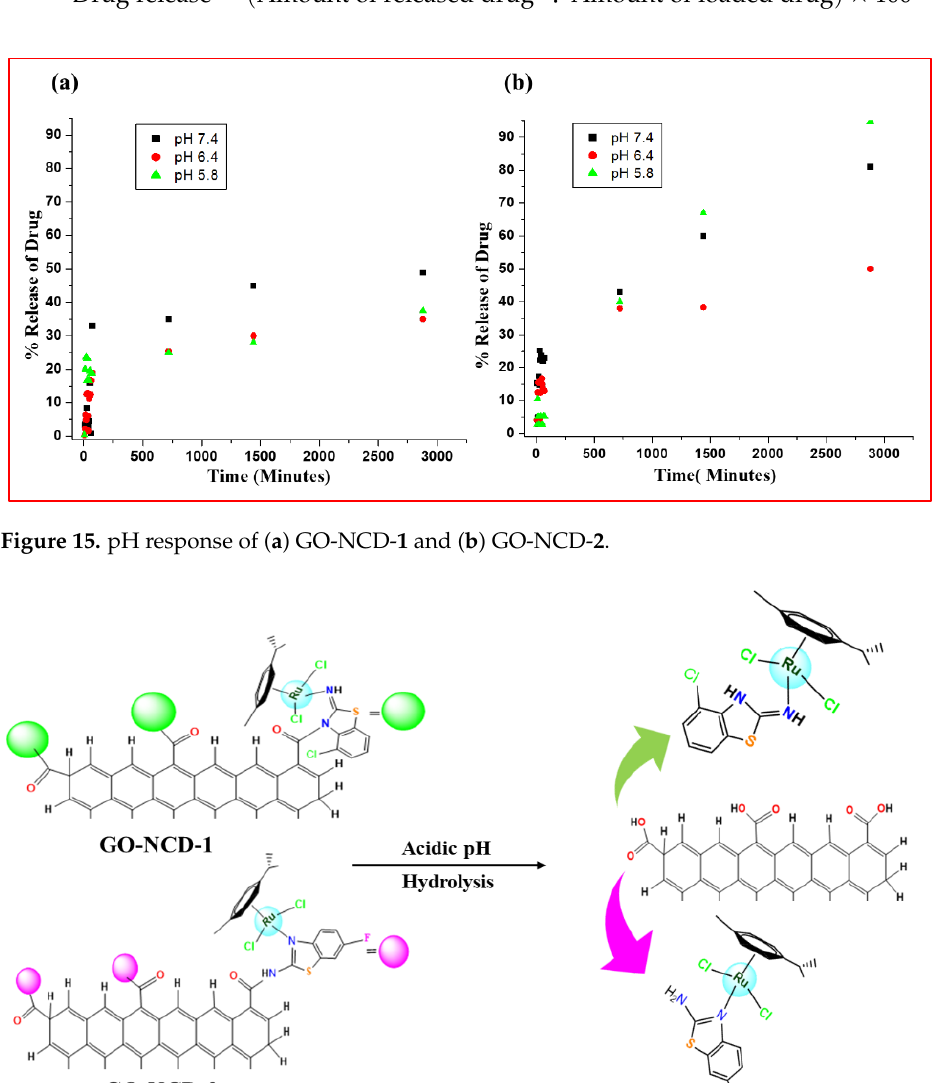
13 of 19 Figure 14. Docked pose of ( a ) GO-NCD- 1 and ( b ) GO-NCD- 2. 2.5. Drug Loading and Release Profile An important parameter to evaluate the performance of a drug carrier is its drug loading capacity. UV-visible spectroscopy was used to calculate the drug loading capacity of the GO. Both the complexes NCD 1 and NCD 2 were found to exhibit strong absorbance in the 250 nm region, and this wavelength was used to calculate the percentage of drug loaded onto the carrier (Figure S9). In the loading experiment, 100 µL to 1000 µL of 10 −3 M NCD 1 and NCD 2 were added continuously to 1 mL of 10 −3 M GO followed by ultrasonication, and a decrease in the absorbance intensity of the complexes was observed up to 800 µM and 600 µM, respectively, after that, no significant change in intensity was observed, suggesting a maximum loading of the drug per mL of 1 mM of GO [45]. The concentration of GO was estimated from the absorbance peak at 250 nm. The 80% and 60% encapsulation for both the complexes were calculated using the Equation (4): Encapsulation capacity = (Amount of Drug loaded on GO ÷ Total amount of drug) × 100 (4) The release behavior of the drug was studied at pH values of 7.4 (physiological pH),